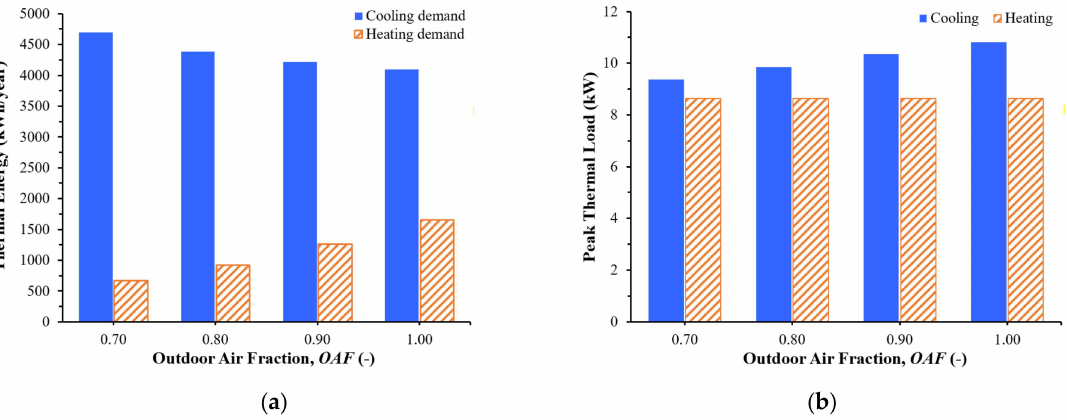
Figure 7. Influence of enhanced mechanical ventilation using outdoor air on ( a ) annual cooling and heating demands; ( b ) peak cooling and heating loads of a conditioned indoor space served by the CAHS (Figure 2a).